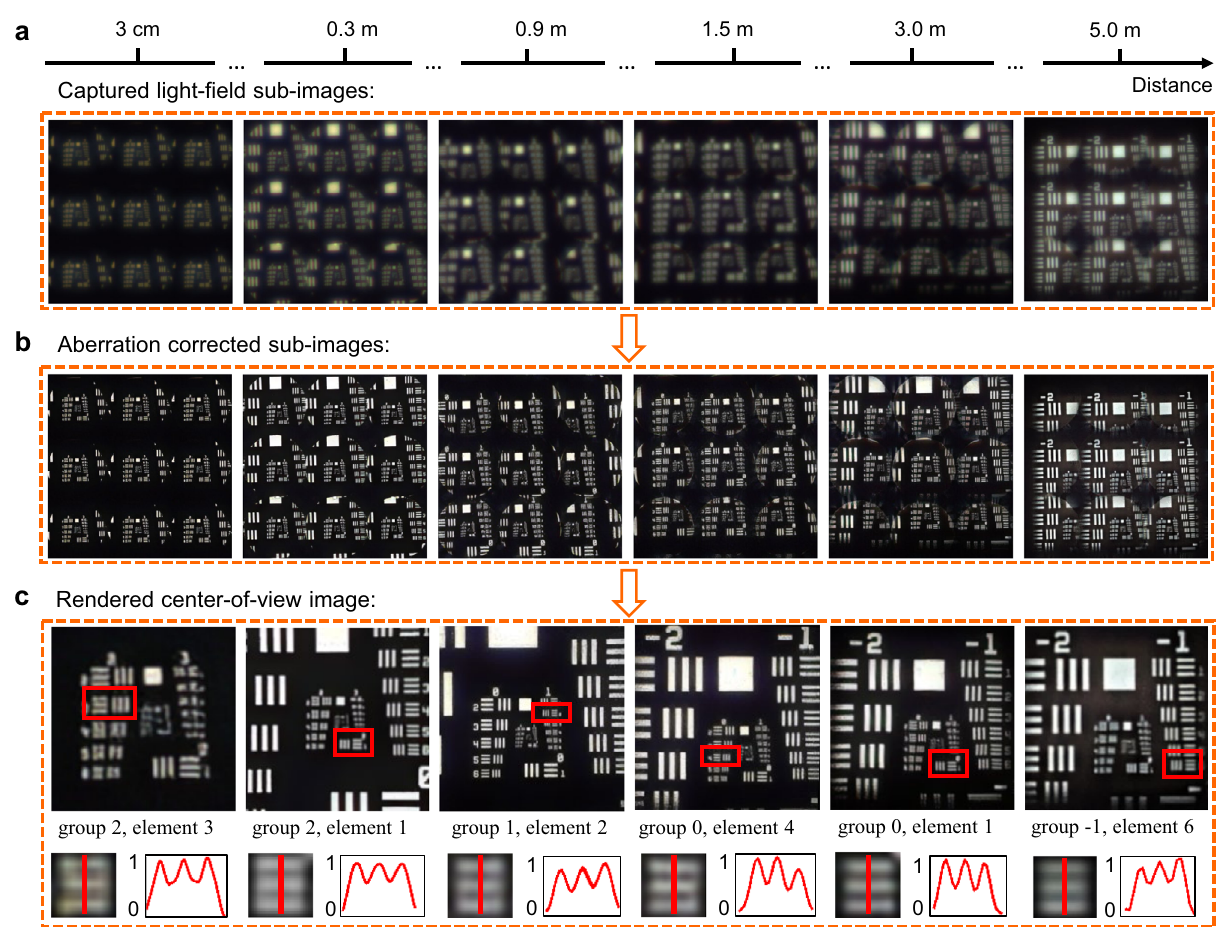
Fig. 5 Resolution evaluation of the proposed light- fi eld imaging system. a Captured subimages of a USAF 1951 resolution chart at different depths. For easy recognition, here we show the 3×3 subimages. b Aberration-corrected subimages. c Top: Rendered center-of-view images of the USAF 1951 resolution chart. Bottom: Zoom-in images and intensity cross sections of each smallest-resolvable line pair in the resolution